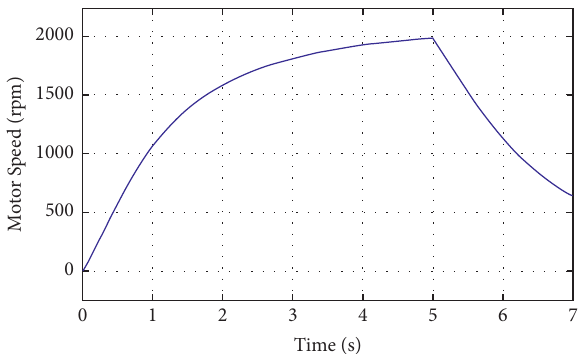
Figure 17: Motor speed characteristics during motoring and regenerative